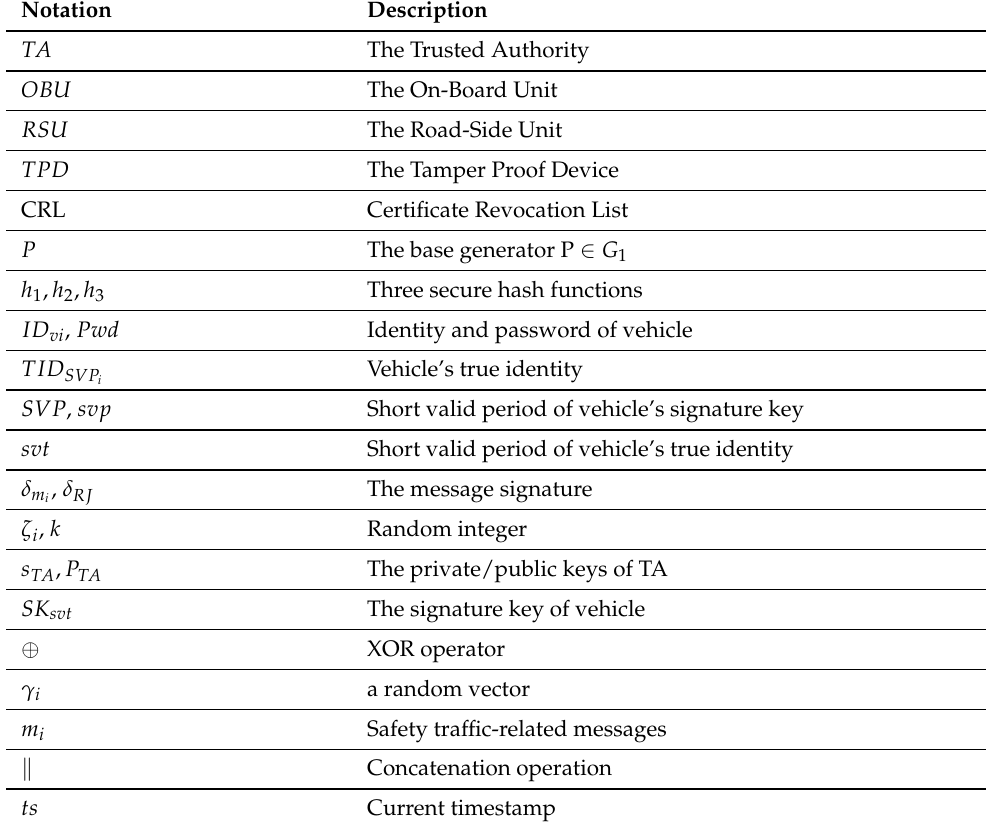
Table 1. Notation and their